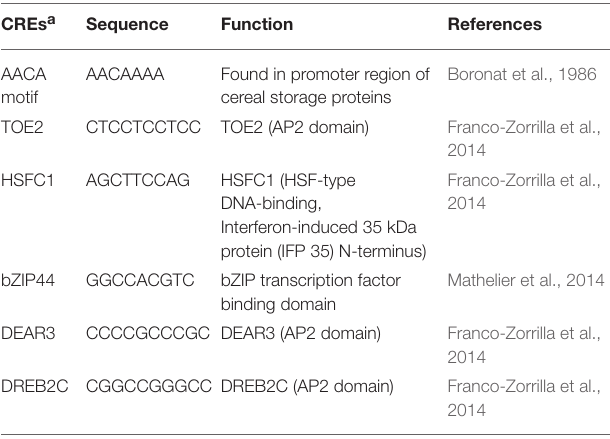
TABLE 1 | Summary of cis -acting regulatory elements identified in rice in response to water